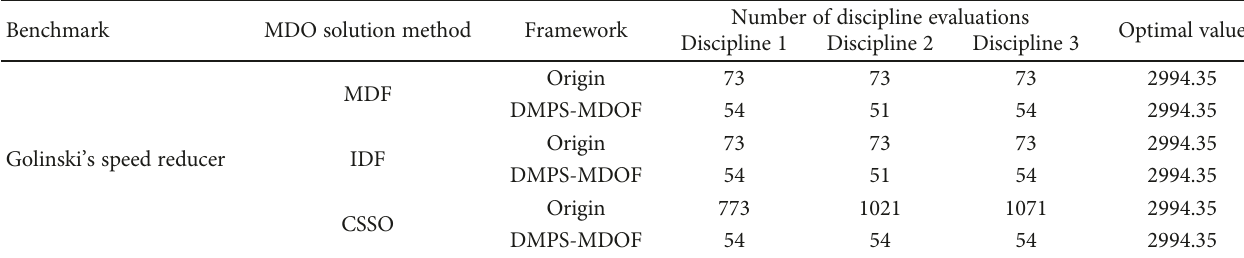
Table 4: Result comparison of the Golinski ’ s speed reducer problem.